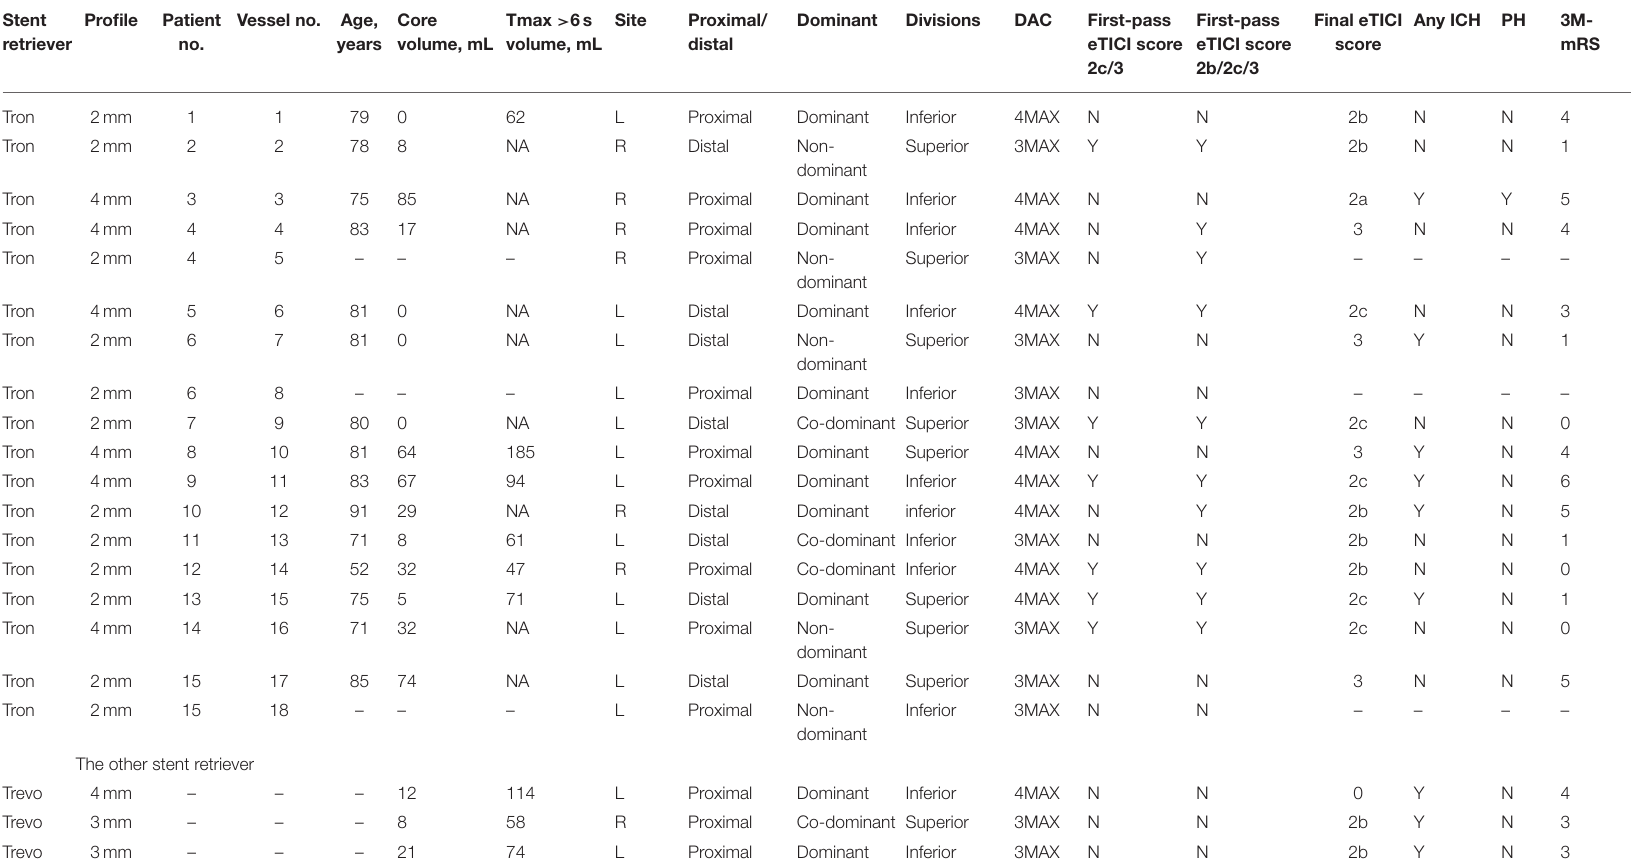
TABLE 2 | The clinical characteristics and outcomes in MCA M2 occlusion patients undergoing the BEMP technique using the Tron vs. other stent retrievers. Stent Profile Patient retriever